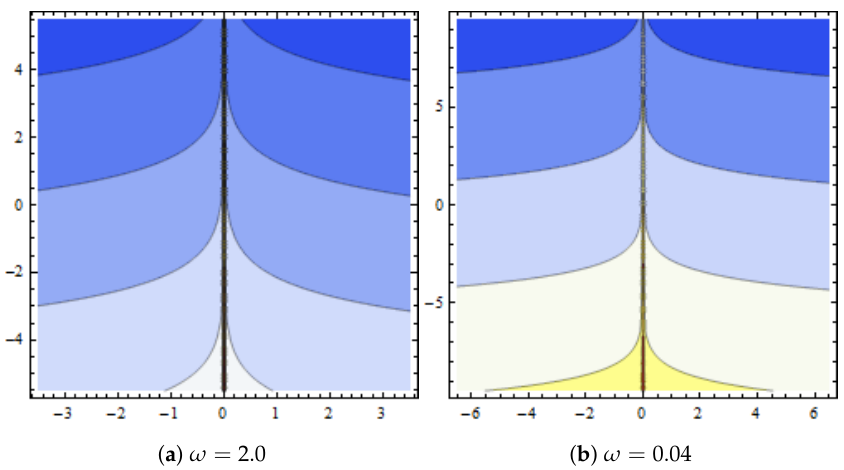
Figure 10. Dynamical behaviour of u ( x , t ) in Equation (32) presented with β 1 = 1.2, β 2 = 0.2, β 3 = 3.5, ζ = 0, l 2 = 0.3, l 4 = 4.2, l 6 = 1.6, Q = 0.5, r 1 = 1.5, r 2 = 2.5, w = 3, w 1 = 2.5, and φ = 1.3. ( a , b ) show contour plots for various values of ω .